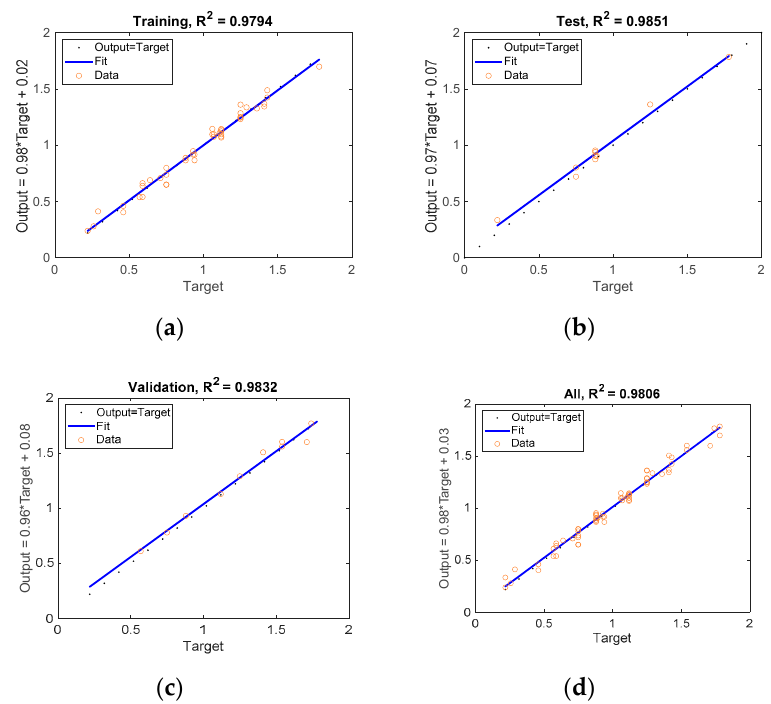
Figure 11. ANN ( n = 2 neurons) results for 𝑓 (cid:2869) ( a ) Train data; ( b ) Validation data; ( c ) Test data; ( d ) All data.